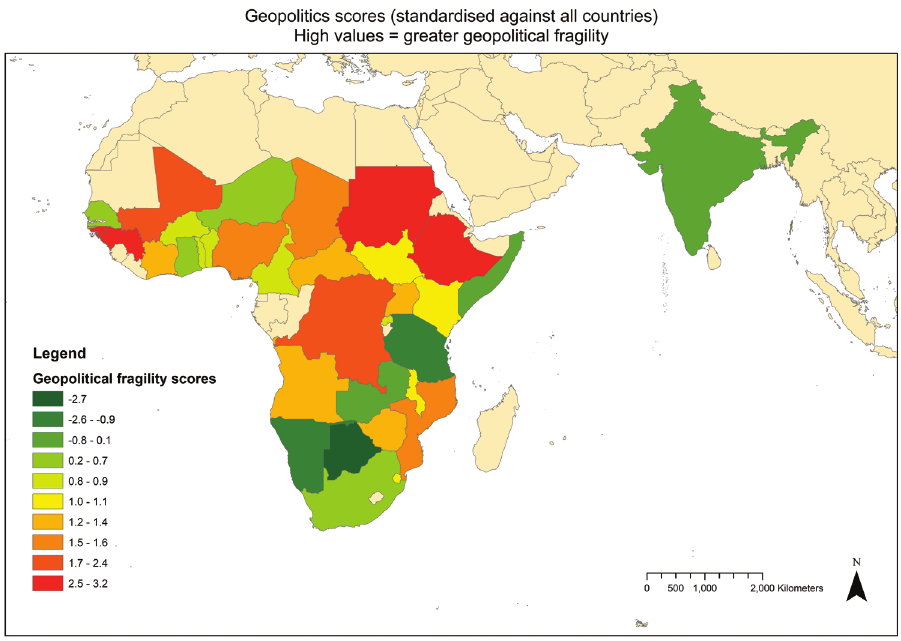
Figure 3. The map shows the geopolitical values of lion range states, where higher values represent greater fragility in the infrastructure of the state (based on Dickman et al.,